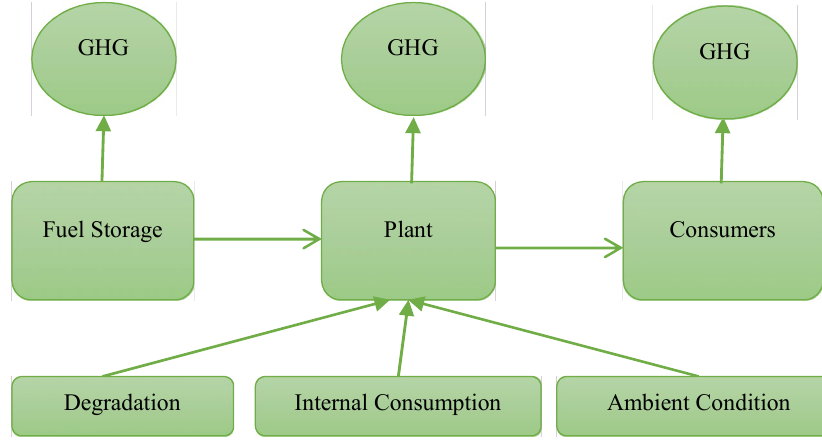
Fig. 1: Life cycle phase block diagram of the process